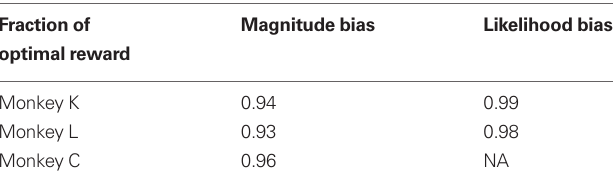
Figure 2 | reward magnitude bias. Psychometric functions for the first four recording session in the reward magnitude condition: the black color corresponds to the neutral condition averaged over all 4 days. The red and green colors correspond to trials in the slow and fast category bias condition, respectively. In order to visualize the effect of the direction bias we separated the trials into two conditions: The so called “slow direction bias” condition incorporates all trials where the red target could be reached by a saccade in the biased direction, i.e., red target on the left side during leftward bias and red target on the right side during the rightward bias. Similarly, the “fast direction